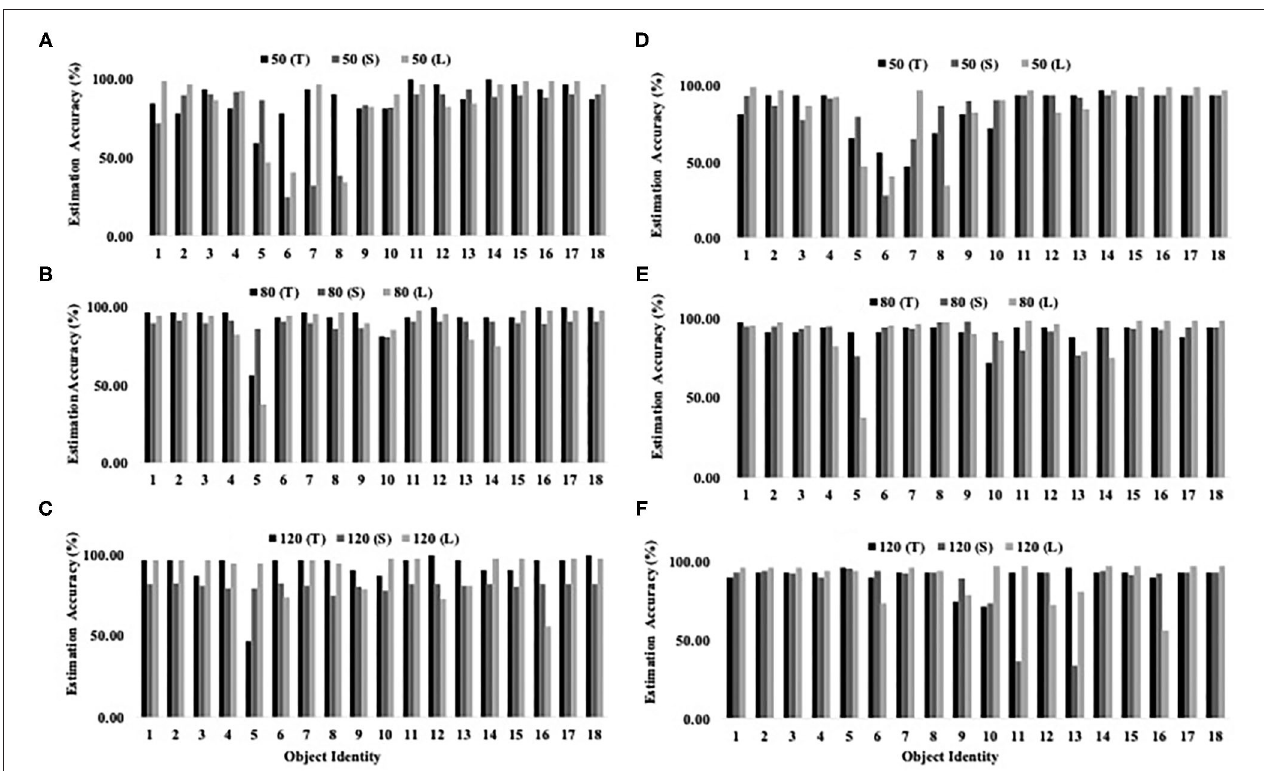
FIGURE 9 | Estimation accuracy of grasped object stability by three networks (T, Triplet network; S, Siamese network; L, LSTM network) at three different pneumatic pressure (50, 80, and 120 kPa). Graph (A–C) were produced by comparing the query objects with reference object 19. Graph (D–F) were produced by comparing the query objects with reference object